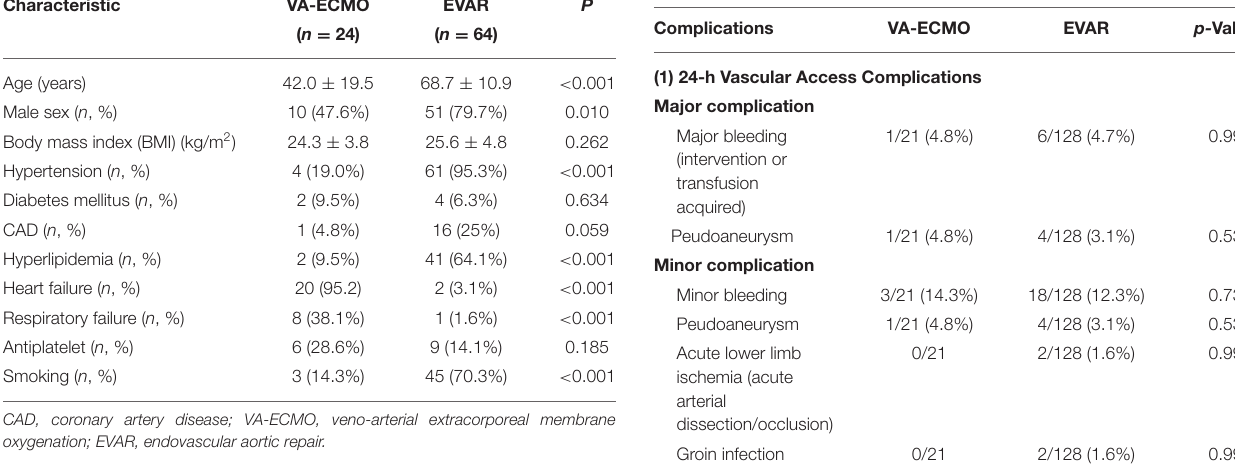
TABLE 3 | Periprocedural and 30-day complications of VA-ECMO and EVAR patients.